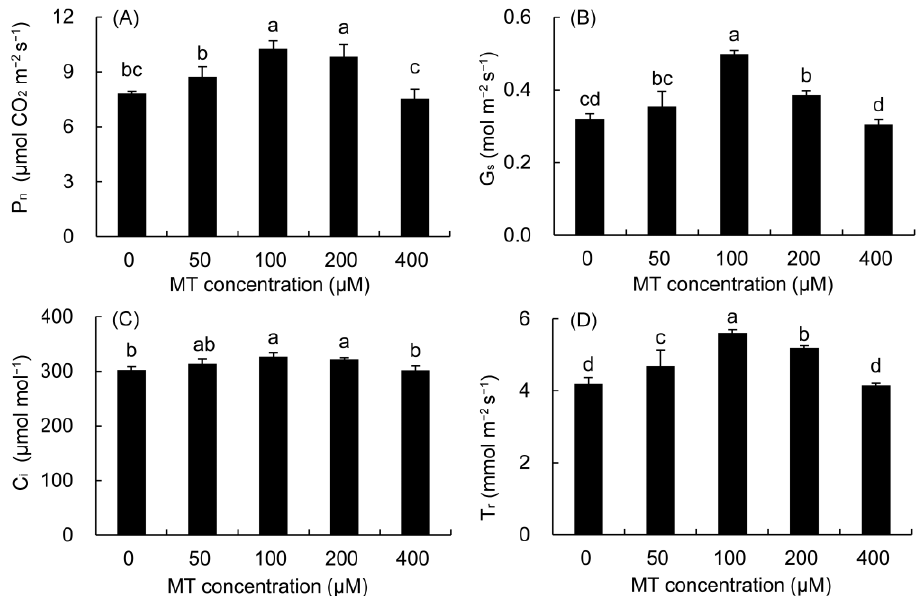
Figure 4. Effects of different concentrations of MT on P n ( A ), G s ( B ), C i ( C ) and T r ( D ) of P. vulgaris. MT: melatonin. Data are means ± standard error; different letters indicate significant differences as determined by the Duncan test ( p ≤ 0.05).